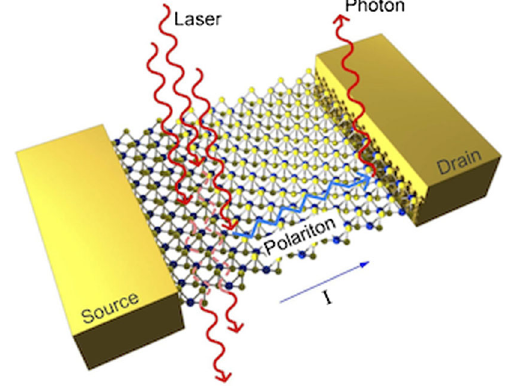
FIG. 1. Schematic of the experimental setup. A photon is absorbed by the TMD monolayer, forming a polariton that is then dragged by the drifting electrons and subsequently emitted at a different